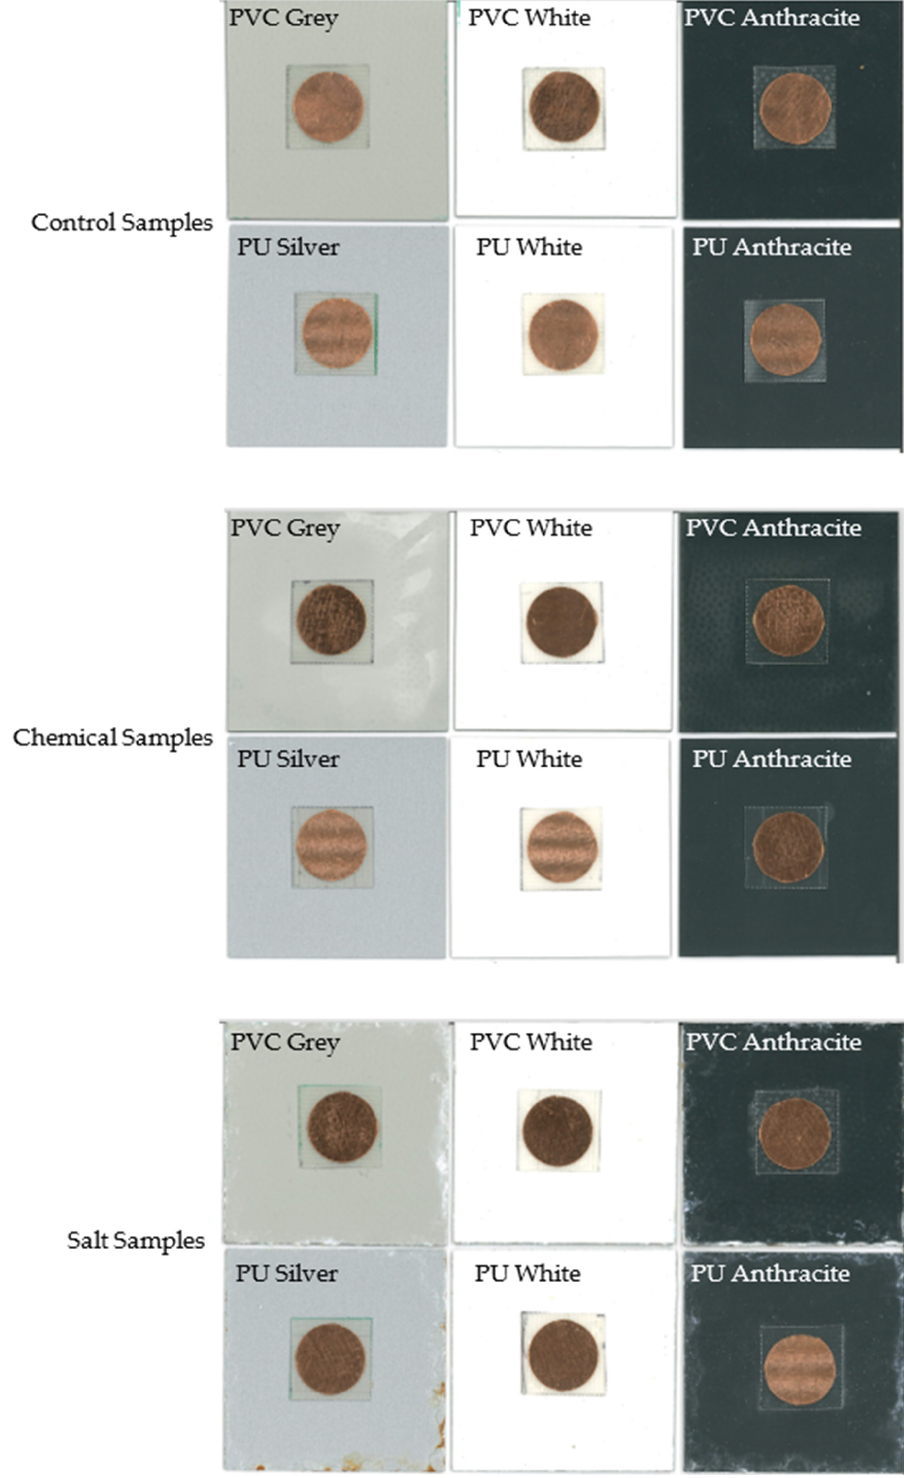
Figure 17. Sample appearance after no testing (control) ( top ), chemical ( middle ) and salt ( bottom ) exposure testing.